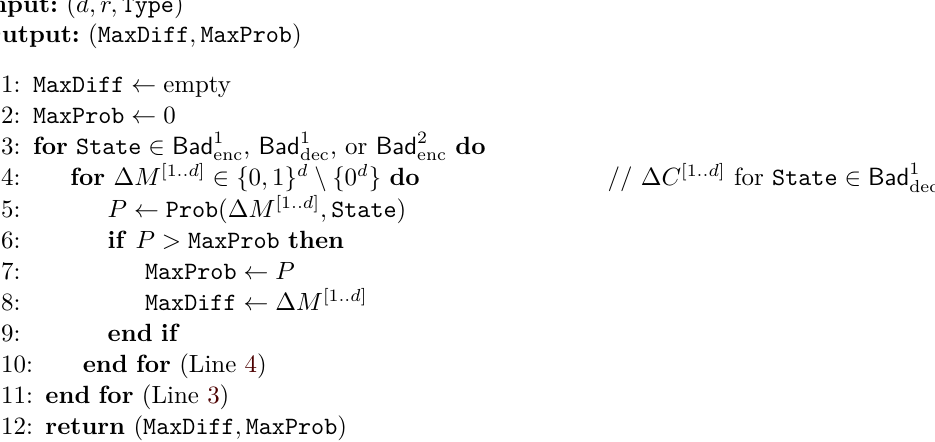
Figure 15: Overview of our program to compute the collision probability of bad conditions. The input Type is used to specify Bad 1